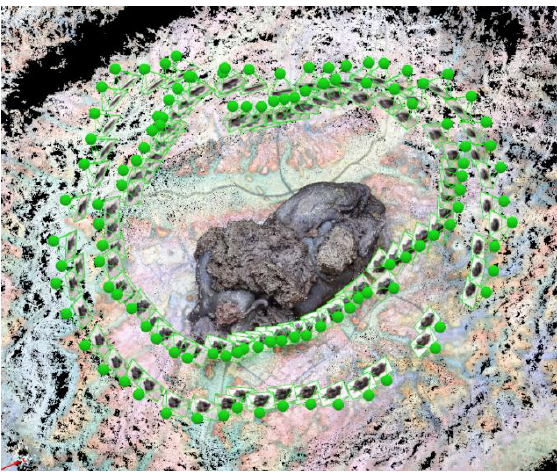
Figure 6. Point cloud A generated from image set A and estimated camera position and rotation